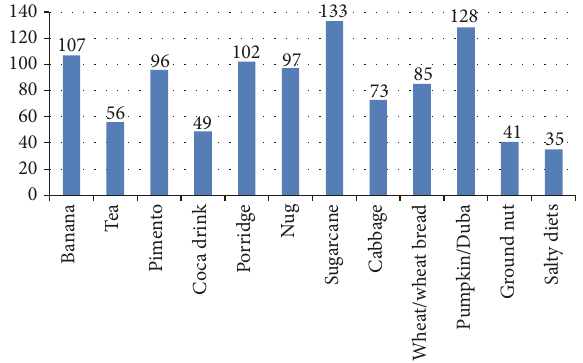
Figure 1: Food taboo in ANC attendants in each food items/drinks in Awabel district, Northwest, Ethiopia, April 15-May 17,